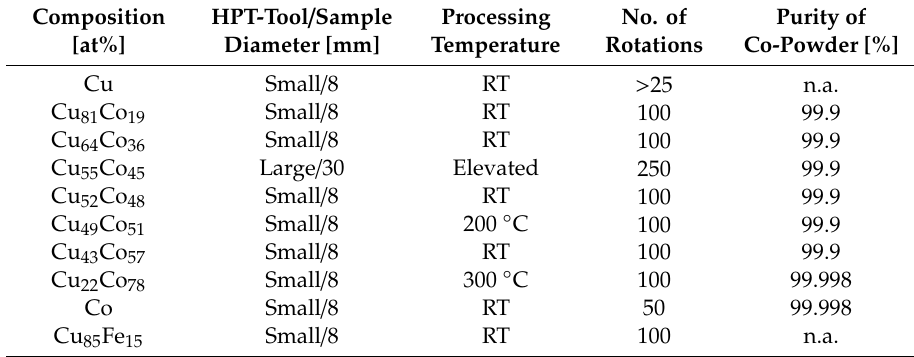
Table 1. Summary of investigated samples, varying in composition (energy dispersive X-ray -measurement) and processing parameters including HPT-tool size, processing temperature, number of rotations, and purity of the used Co-powder (where